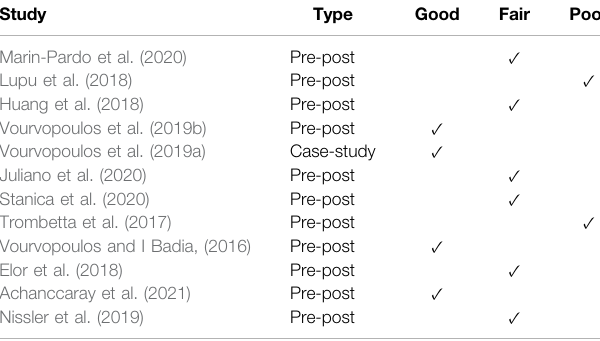
TABLE 4 | NIH quality assessment results for included studies.